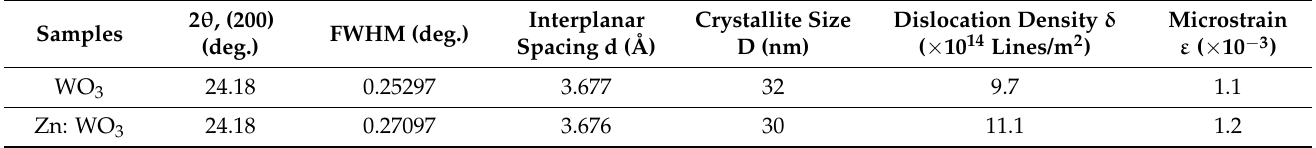
Figure 1. XRD patterns of WO 3 and Zn: WO 3 films. Figure 1. XRD pa(cid:308)erns of WO 3 and Zn: WO 3 films. Table 1. Structural parameters of the films extracted from XRD Table 1. Structural parameters of the films extracted from XRD pa(cid:308)erns.